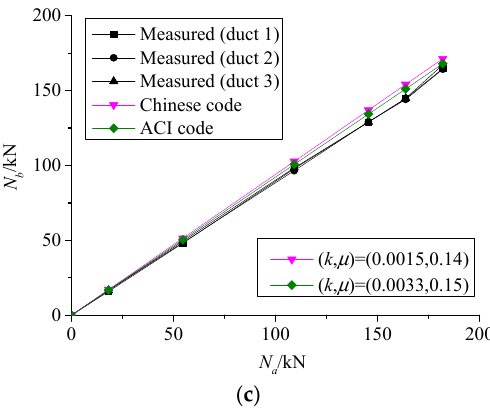
Figure 15. Pre-stress forces of specimens with a single-wire and curve duct based on Wujiang Bridge made of: ( a ) rubber hose; ( b ) metal bellow; and ( c ) plastic bellow.